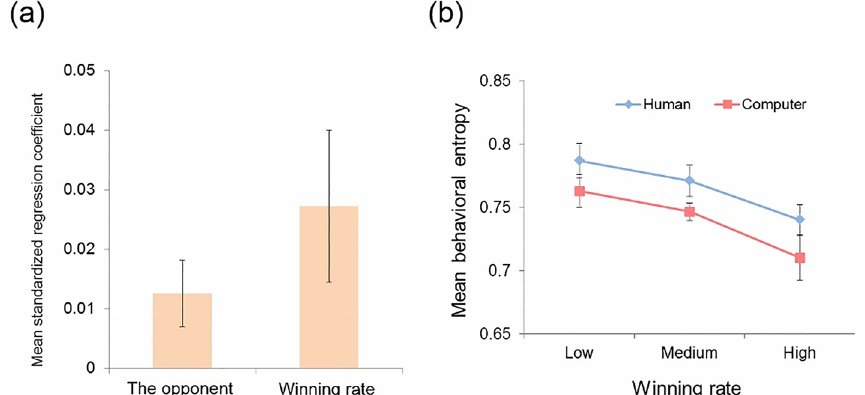
Fig 2. Behavioral results. ( a ) Results from multiple regression analysis. Standardized beta coefficients associated with behavioral entropy are depicted. The wining rate was entered into the regression analysis as the amount of money the subjects earned in each block, multiplied by -1, so that the positive beta coefficients indicate a negative association between the winning rate and entropy. ( b ) The level of behavioral entropy in each condition (human or computer condition) as a function of the winning rate (high, medium, or low). Higher entropy indicates that subjects ’ responses were more random, while lower entropy indicates that their responses were more